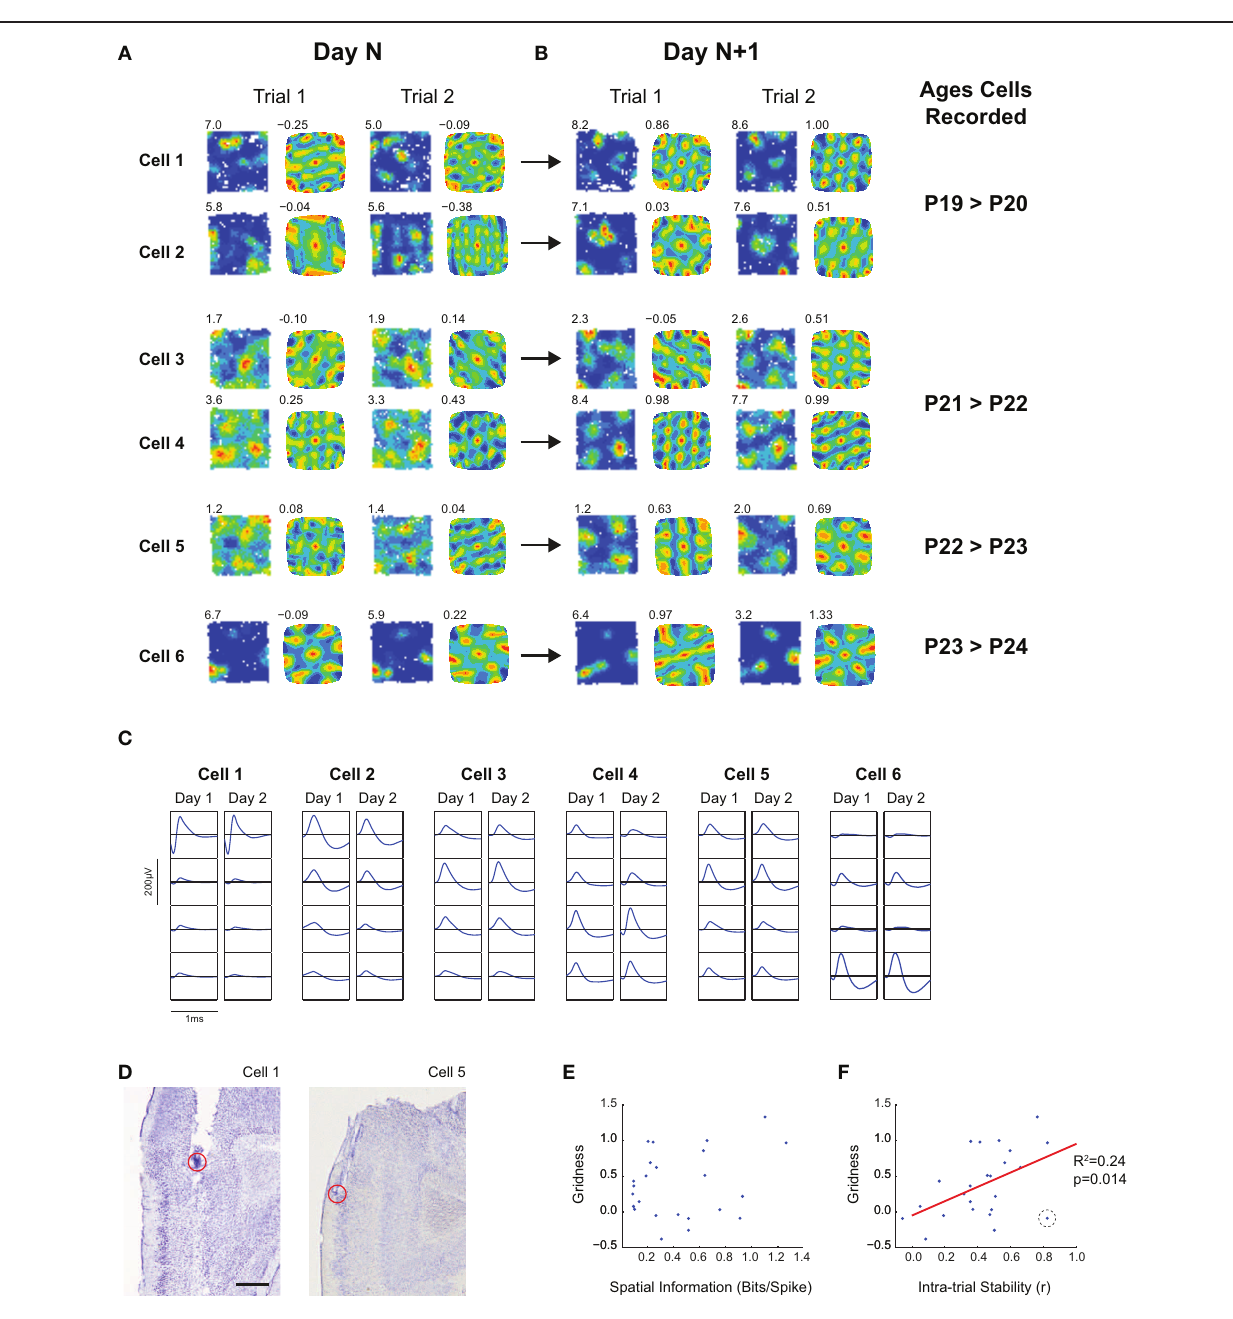
score. The vertical and horizontal scale bars (200 μ V and 1ms, respectively) apply to all waveform plots. (D) Estimated recording locations for cells shown in (A) for which recording locations are not shown elsewhere in the paper. For the recording location of Cell 2, see Figure 3G ; for Cell 3–4, see Figure 2E , “Rat 1”; and for Cell 6 see Figure 3F . Scale bar = 0.5mm. (E,F) Scatter plots of Spatial Information (E) and Intra-trial stability (F) against Gridness. Each point represents a trial on Day N or Day N + 1 [i.e., all trials shown in (A) ]. There is a significant relationship between Gridness and Intra-trial Stability ( R 2 and p value for linear regression shown to right of plot), but not for Gridness and Spatial Information. The data point in (F) highlighted by a black dashed circle, which has a high stability but low gridness, corresponds to Cell 6, Trial 1 on P23 (see text for